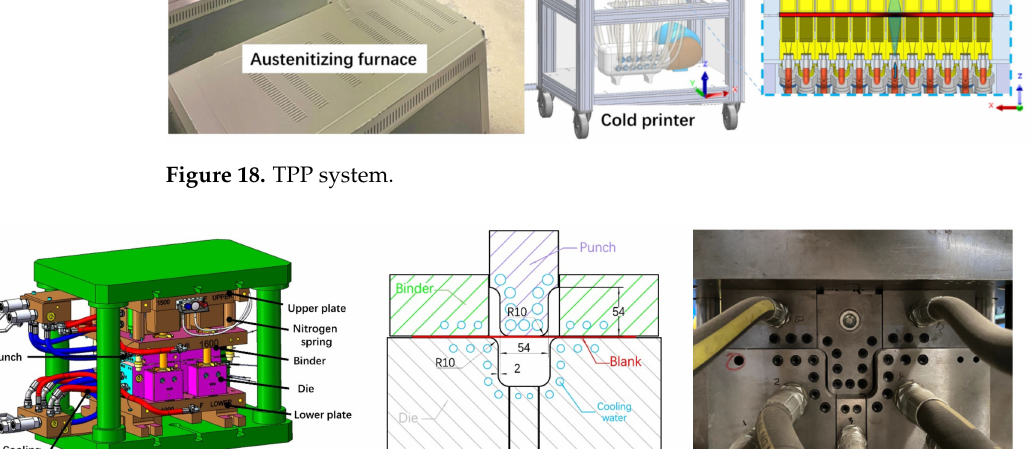
Figure 19. Die system for hot forming U-shaped